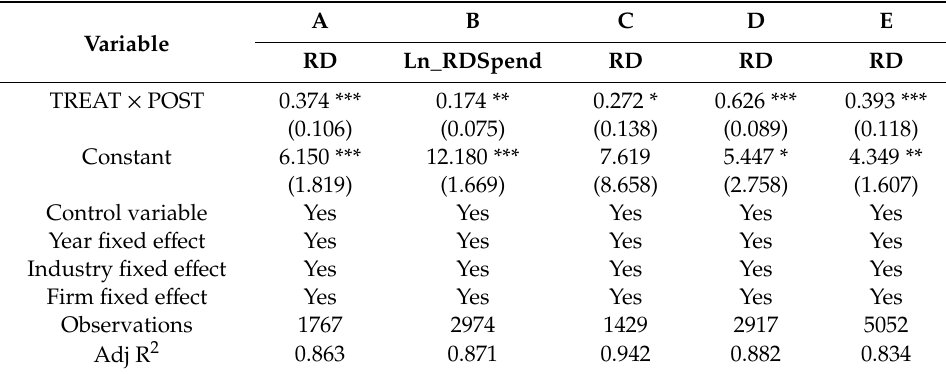
Table 5. Robustness